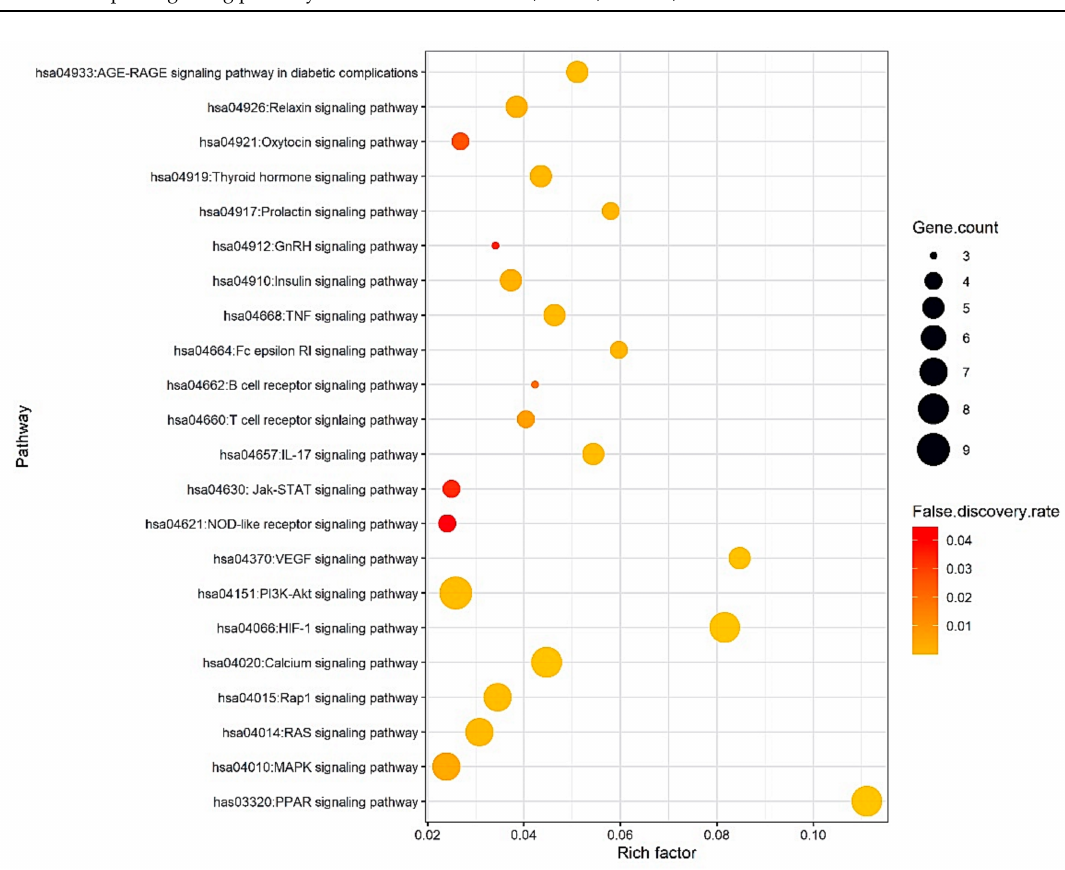
Figure 5. Bubble chart of ICLs against